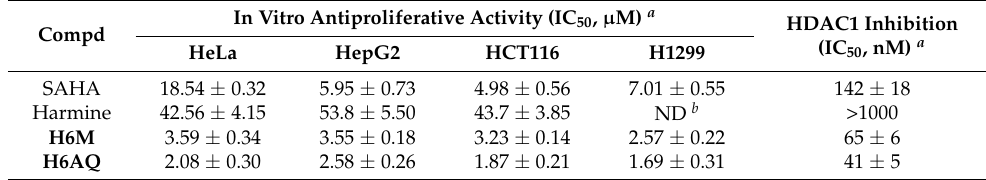
Table 1. IC 50 Values of H6M and H6AQ against HDAC1 and four cancer cell lines.